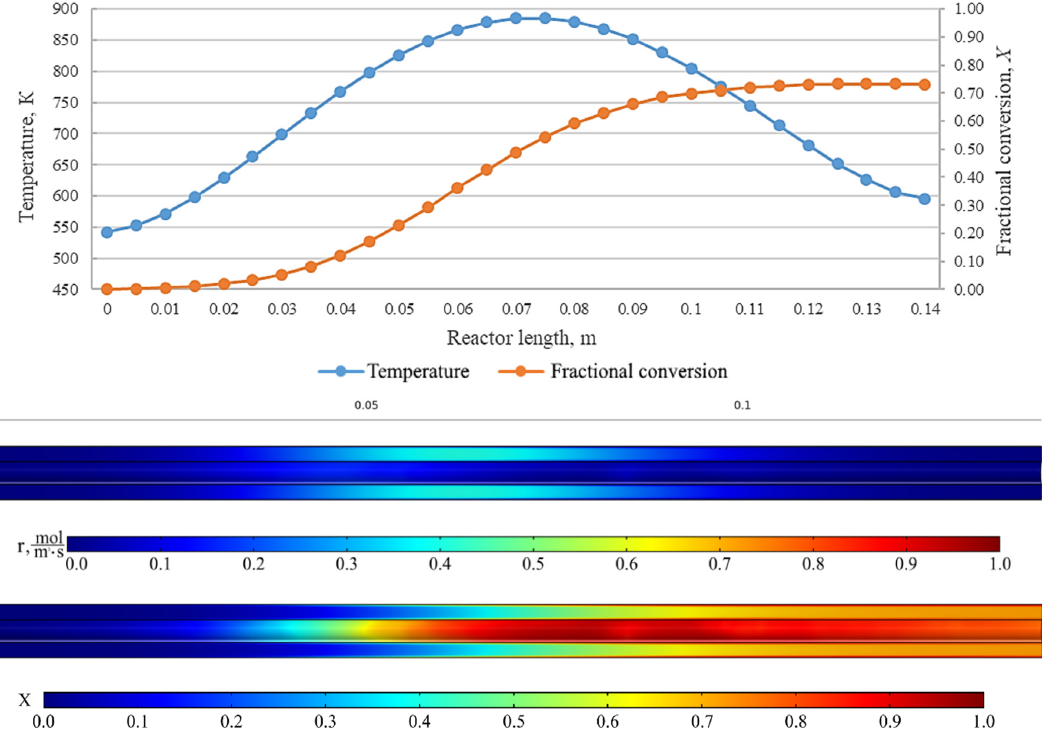
Figure 16. From top to bottom: temperature and fractional conversion curves, profiles of the reaction rate and fractional conversion along the reactor length for the experiment BuOm_600_82 (Tmax = 600 °С , 𝑉(cid:4662) = 0.15 L/min).